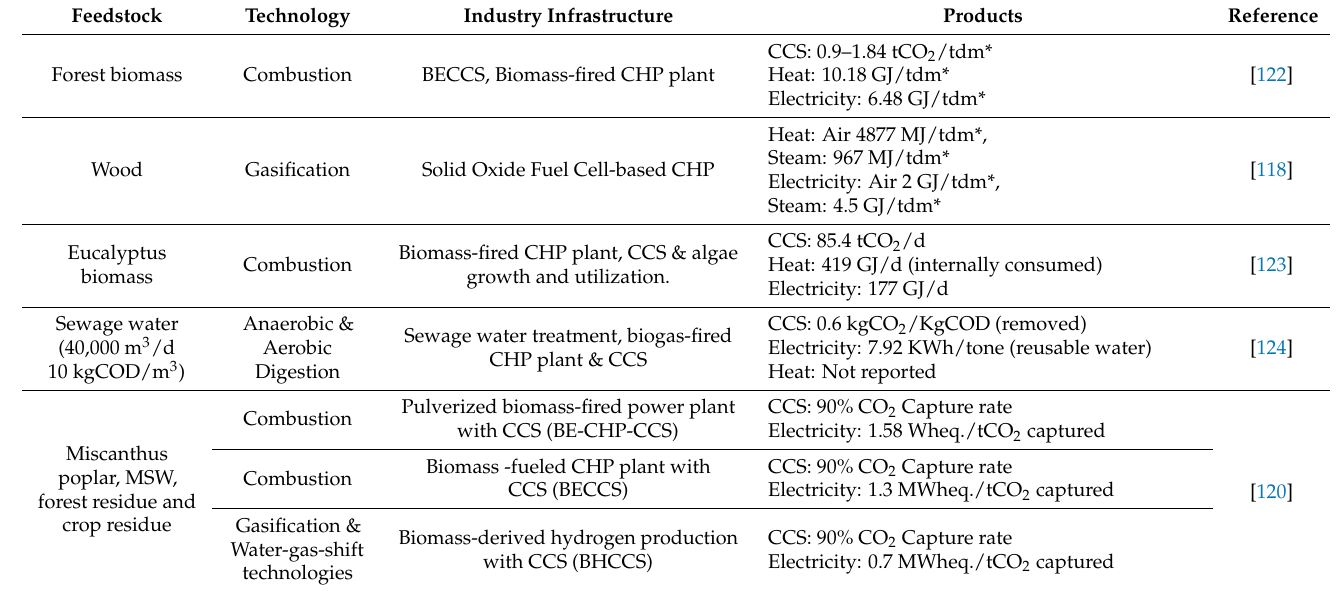
Table 4. Examples on the Integration of biorefineries with other